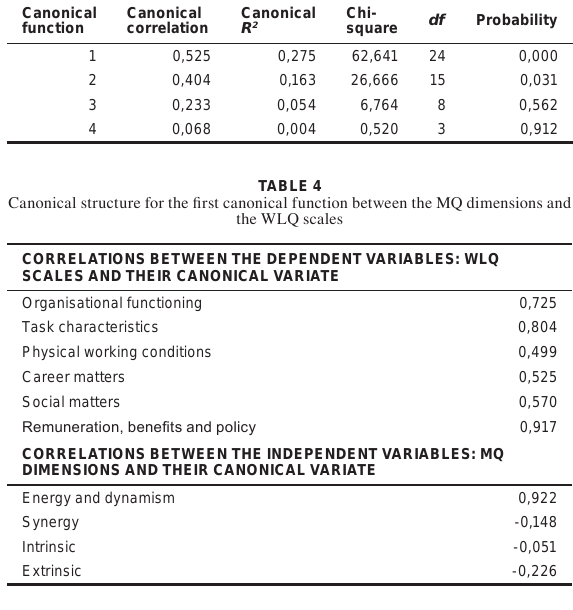
Table 3 Canonical correlation analysis for the MQ dimensions and the WLQ measures of overall model fiT for canonical correlaTion analysis